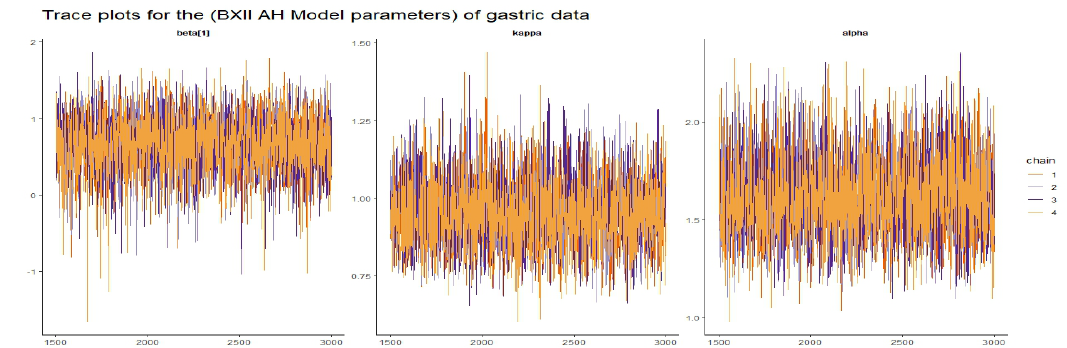
Figure 8. The W–AH model posterior parameters trace plots of the gastric cancer data.